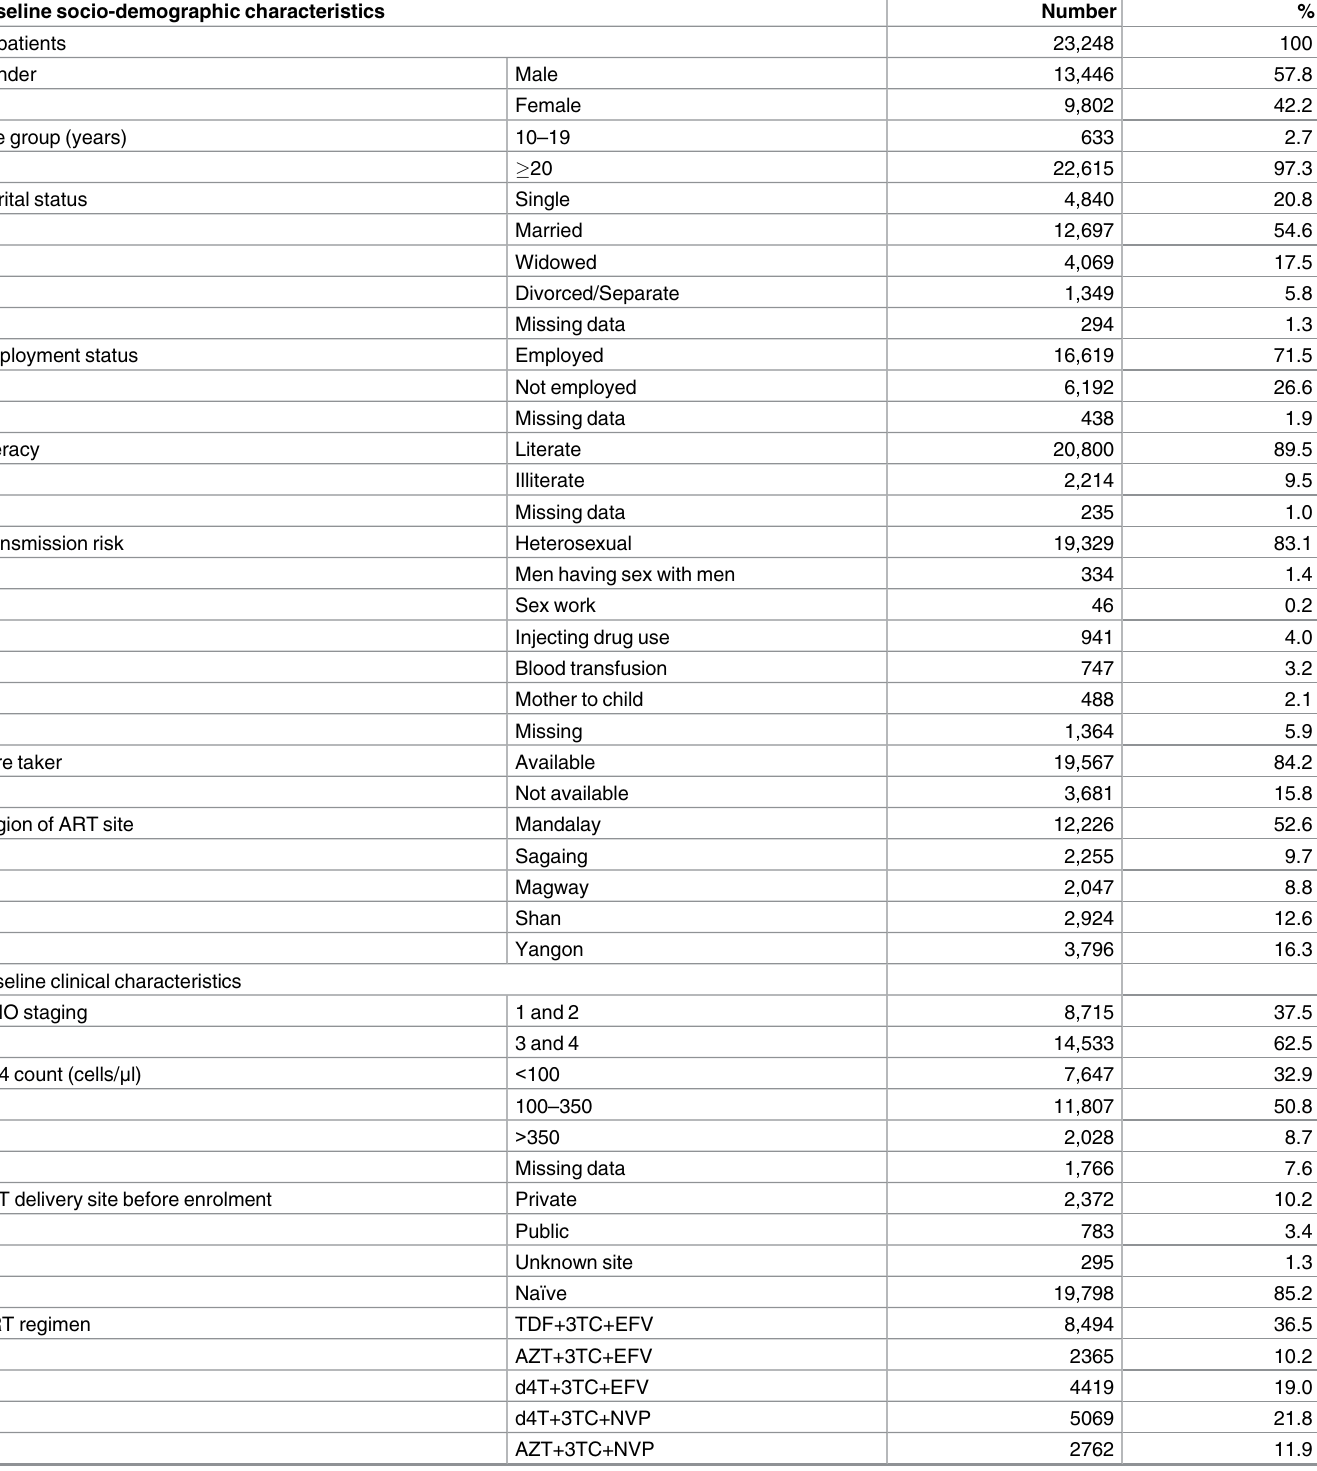
Table 1. Socio-demographic and clinical characteristics of patients who receivedfirst-line ART regimen at the Integrated HIV Careprogram, Myan- mar, between 2005 and 2015. Baseline socio-demographic